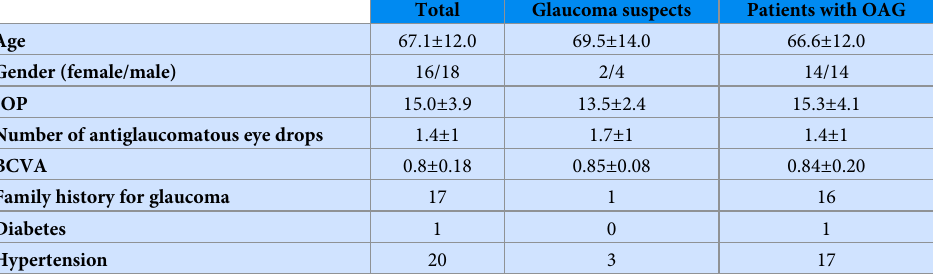
Table 1. Demographic data for total cohort and subdivided into glaucoma suspects and glaucoma patients: Age, gender, intraocular pressure at the day of examination with glaucoma therapy (IOP), number of antiglaucoma- tous eye drops, best corrected visual acuity (BCVA): Mean ± SD; number family history of glaucoma, diabetes,